Question: Sum up the contents of this chart in one sentence.
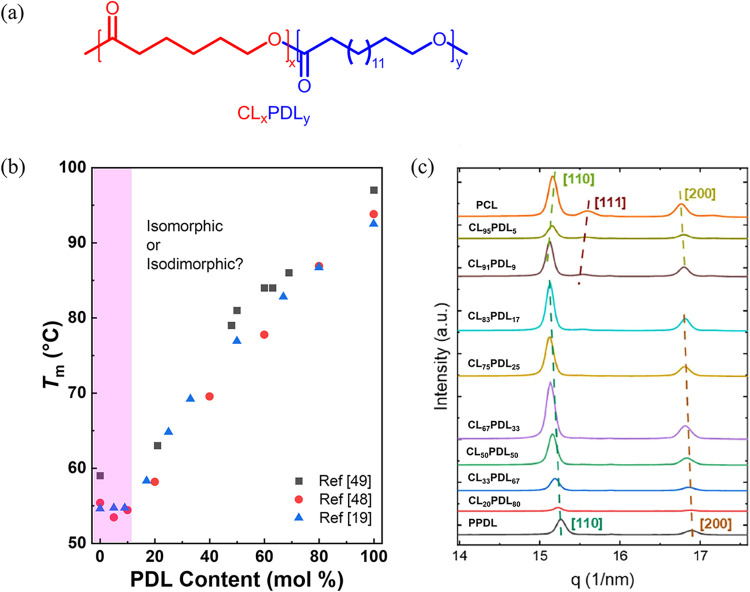
Answer: (a) PDL x CL y chemical structure, (b) comparison of T m vs PDL content of works reported in the literature, , , and (c) WAXS patterns. The shaded region in (b) highlights the compositional interval in which the asymmetric pseudoeutectic behavior, and thus the isodimorphic character of the system, becomes evident. Figure 7 highlights how insufficient compositional sampling may conceal pseudoeutectic behavior and lead to overestimation of strict isomorphic crystallization. Figure 7 is adapted from refs , , and . Copyright 2015, 2005, and 2025 American Chemical Society.